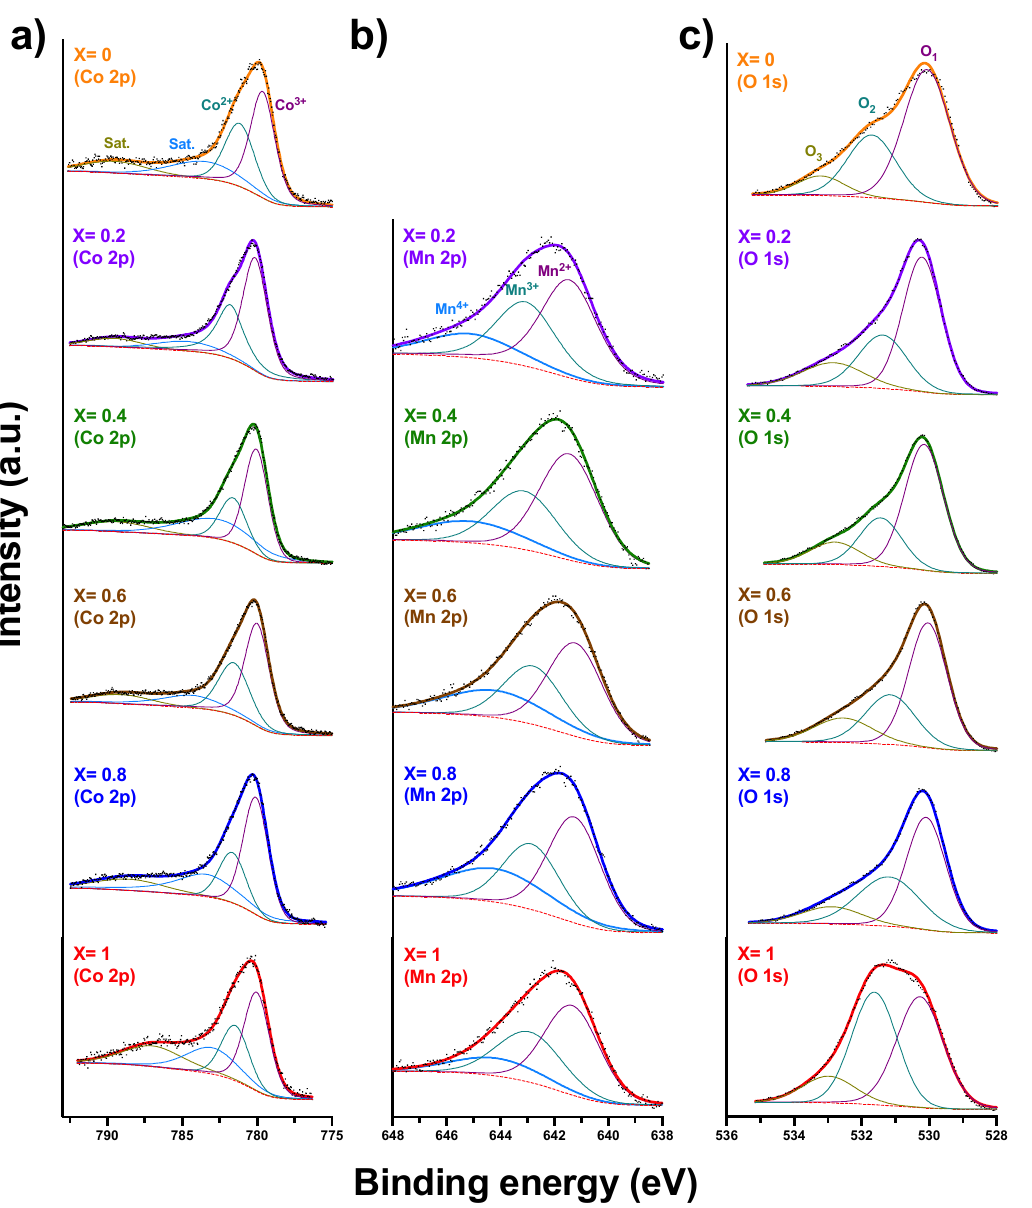
Figure 9. High-resolution XPS spectra of Mn X Co 3-X O 4 (0 ≤ X ≤ 1) for ( a ) Co 2p, ( b ) Mn 2p and ( c ) O 1s.